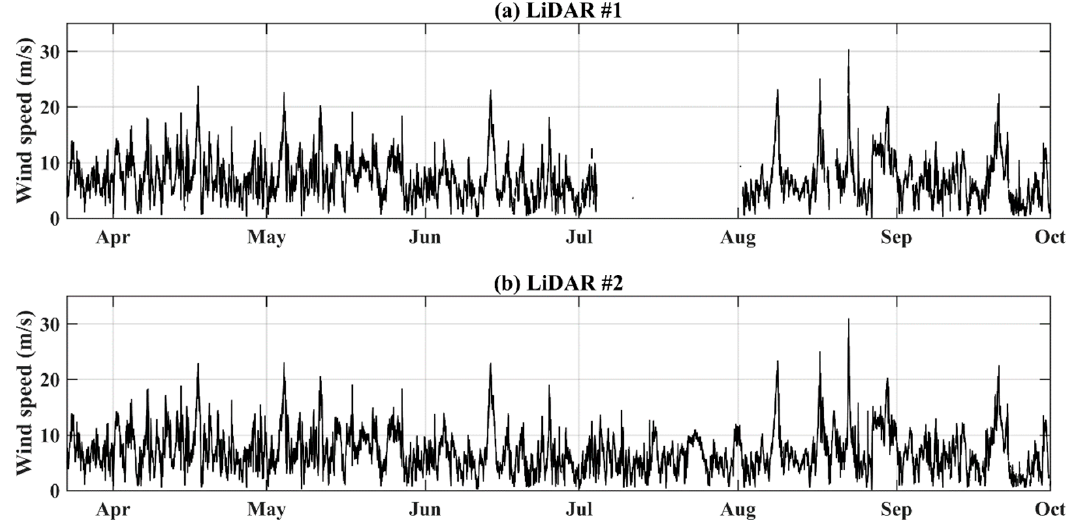
Figure 5. Timeseries of 10 min wind speeds at a height of 100 m for ( a ) LiDAR #1 and ( b ) LiDAR #2 for the period 22 March to 30 September 2016.